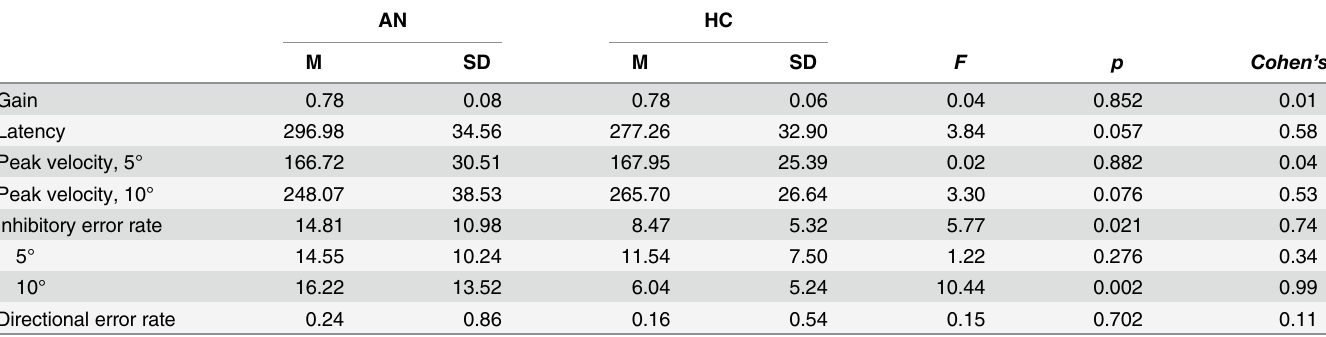
Table 3. Memory-guided saccade task results.